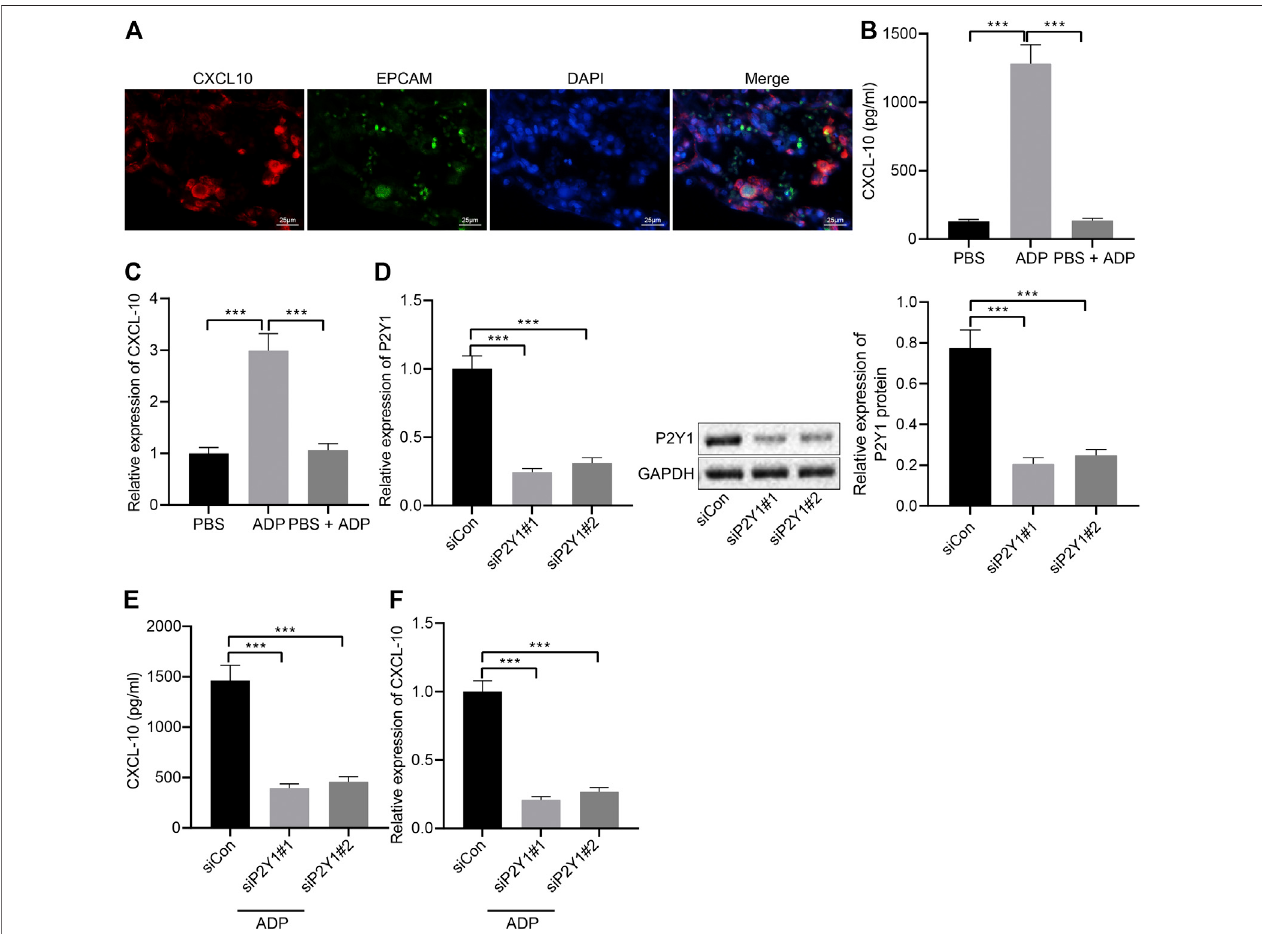
FIGURE 5 | ADP promotes release of CXCL10 through P2Y1 receptor. (A) Representative microscopic images of immuno fl uorescence staining in lung tissues of asthmatic mice. The co-localization of alveolar epithelial cell markers EPCAM and CDH1 (green) and chemokine CXCL10 (red) was observed, and the nucleus was labeledwithDAPI(blue). (B) ThereleaseofCXCL10inalveolarepithelialcellsSW1573afterP2Y1receptorinhibitionbyPSB0739(1 h)andADPtreatment(12 h). (C) The expression of CXCL10 in alveolar epithelial cells after P2Y1 receptor inhibition by PSB0739 (1 h) and ADP treatment (12 h) determined by RT-qPCR. (D) Knockdown ef fi ciency of P2Y1-speci fi c siRNA determined by RT-qPCR and Western blot analysis. (E) CXCL10 release in alveolar epithelial cells SW1573 after P2Y1 knockdown by speci fi c siRNA and ADP treatment. (F) CXCL10 expression in alveolar epithelial cells SW1573 after P2Y1 knockdown by speci fi c siRNA and ADP treatment determined by RT-qPCR. * p < 0.05, ** p < 0.01, and *** p < 0.001. Measurement data were expressed by the mean ± standard deviation, analyzed by independent sample t test, and the experiment was repeated three